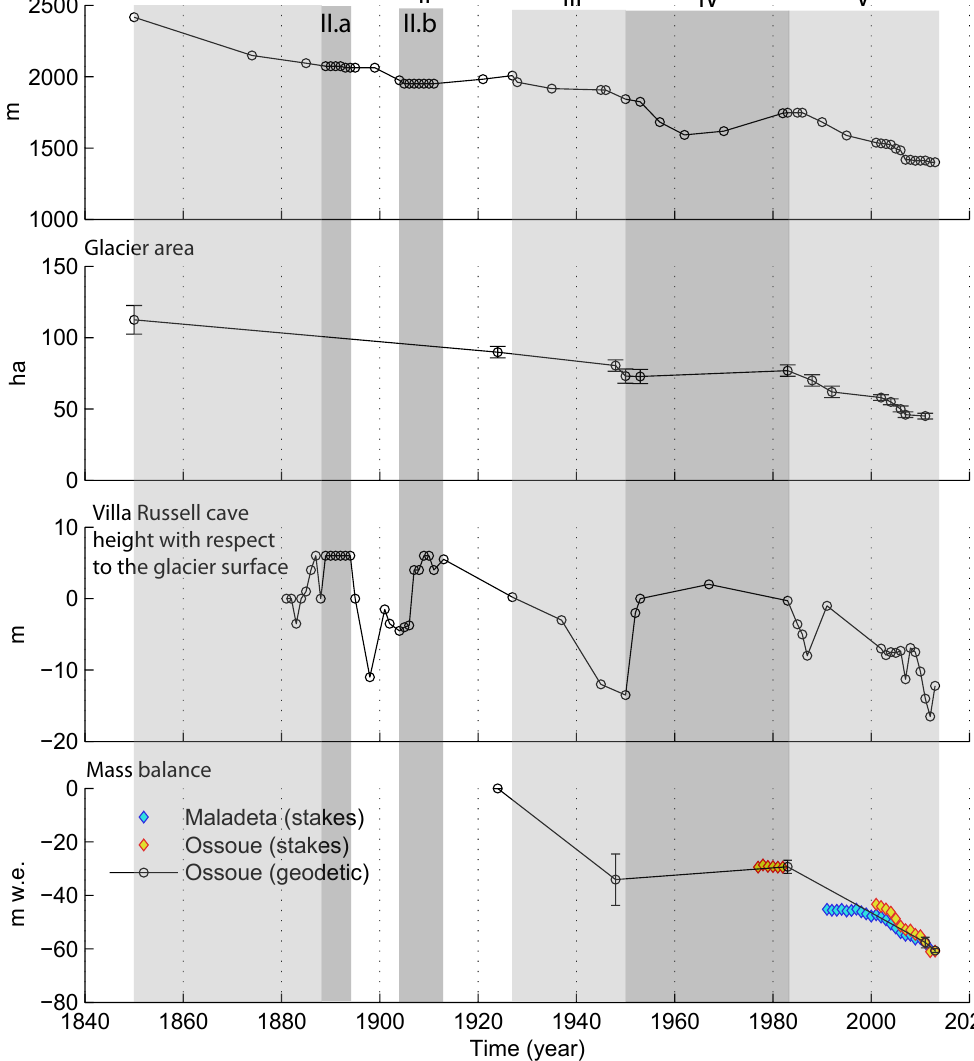
Figure 9. Length (m), area (ha) and thickness (m) at Villa Russell and mass changes (in mw . e . ) of Ossoue Glacier. Glaciological mass balances of Ossoue (orange) and Maladeta (blue) glaciers. The background colour indicates the interpreted trend of the period, according to the metric variations (see Sect. 5.1). The ice depletion periods (I, III, V) are shown in light grey. The periods of accumulation or stability (II.a, II.b, IV) are shown in dark